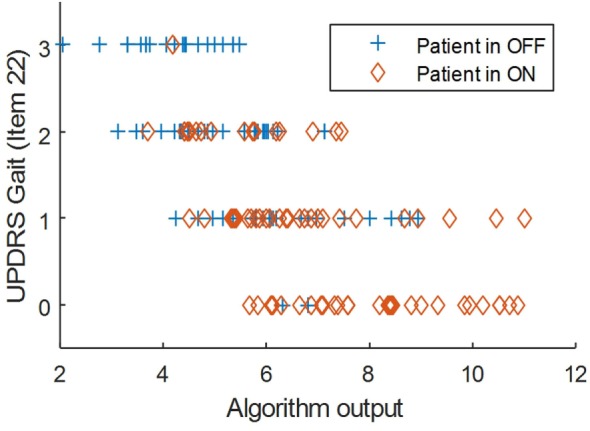
Scatter plot of the algorithm output against UPDRS Gait (item 22).